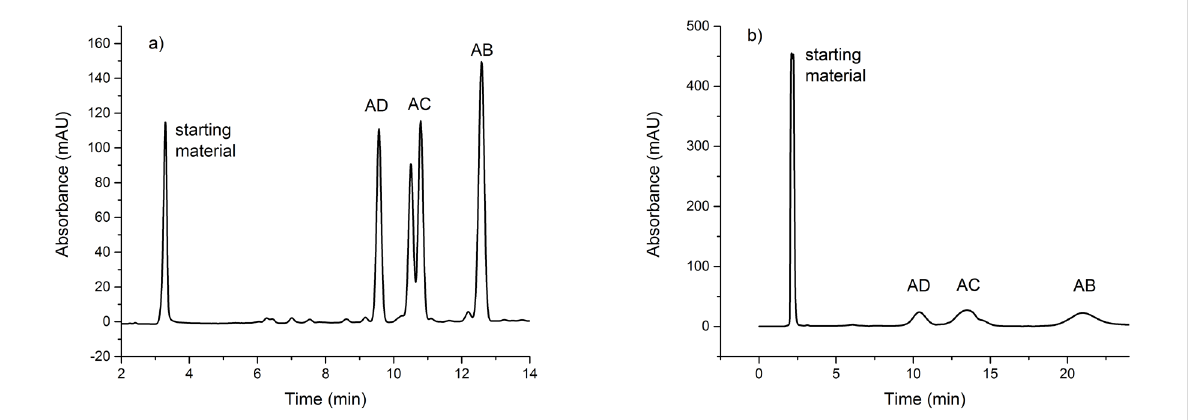
Figure 4: HPLC chromatograms of 6 A -azido-6 X -mesitylenesulfonyl- α -CD 8 (reaction 6): a) analytical and b) preparative scale at 25 °C.